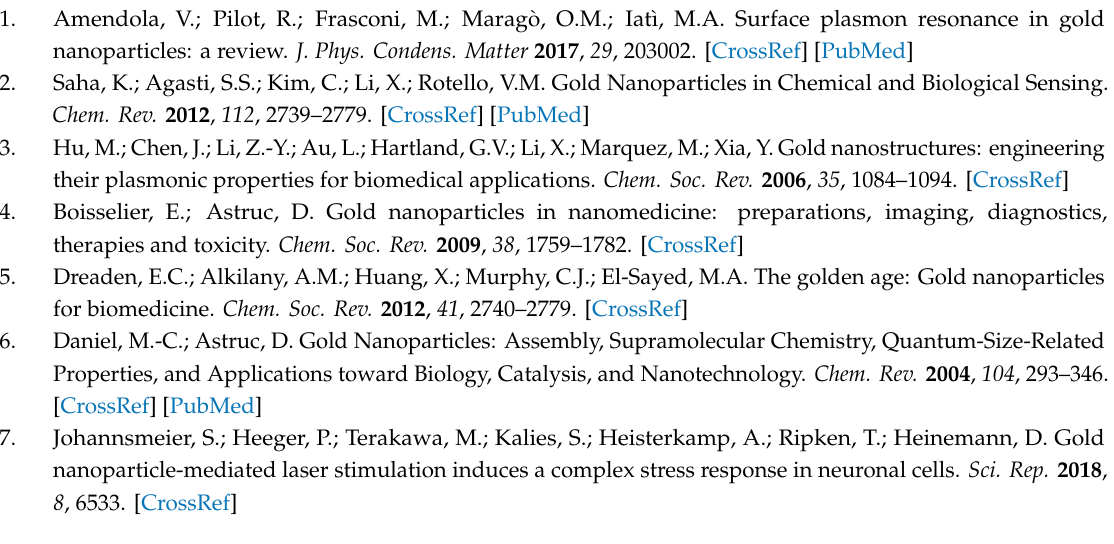
Figure S1: Experimental setup for AuNPs syntheses; Figure S2: Au4f high resolution regions in washed 430-AuNP colloid, Figure S3: UV-Vis absorption spectra of AuNPs synthetized applied an external potential to stainless steel, Figure S4: Comparison of UV-Vis absorption spectra of gold colloids synthetized using AISI 304 stainless steel, with and without adding NaCl, Table S1: Surface chemical composition of steel surface before and after their use, obtained by XPS, Table S2: Surface chemical composition of colloids synthesized with AISI 430, 410 and 304, obtained by XPS, Table S3: Surface chemical composition of washed gold nanocolloids, obtained by